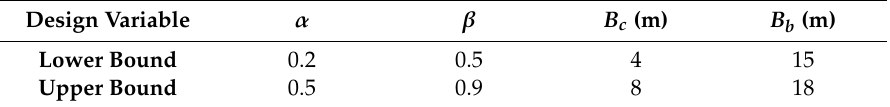
Table 1. Lower and upper bounds of design variables.